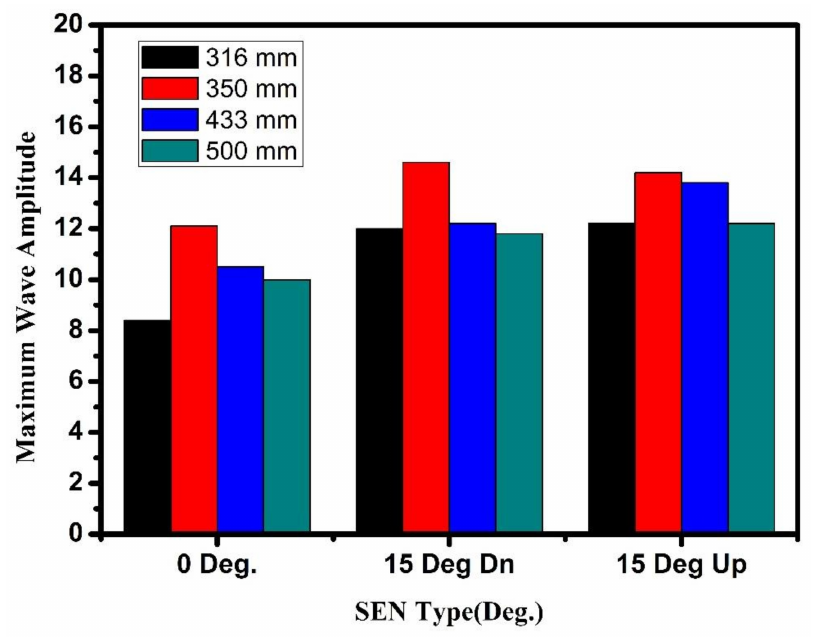
Figure 11. Variation of maximum surface wave amplitude with different nozzle types at 60 L/min liquid flow rate from SEN at different mould